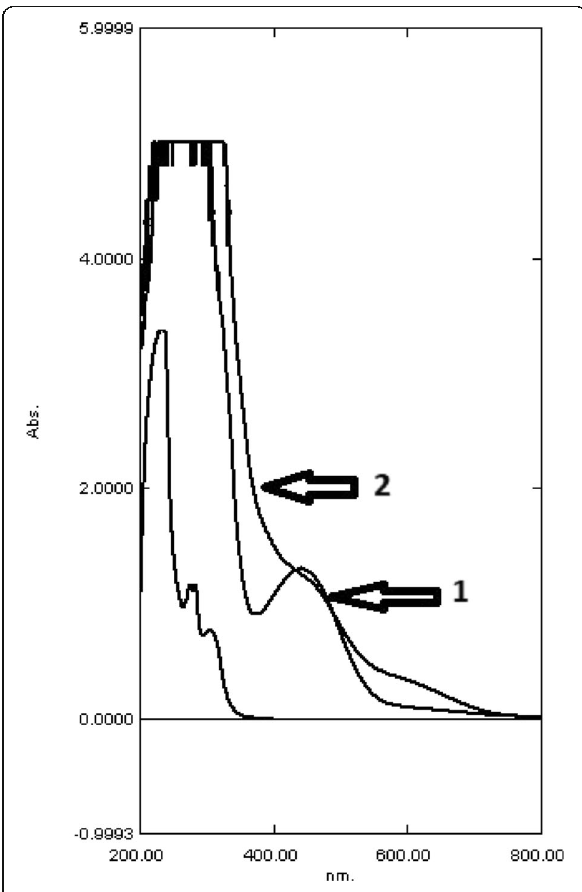
Fig. 2 The absorption spectrum of chlorthalidone alongside methanol (1000 μ g/mL). 1 The reaction product of chlorthalidone with reagent. 2 Blank sample